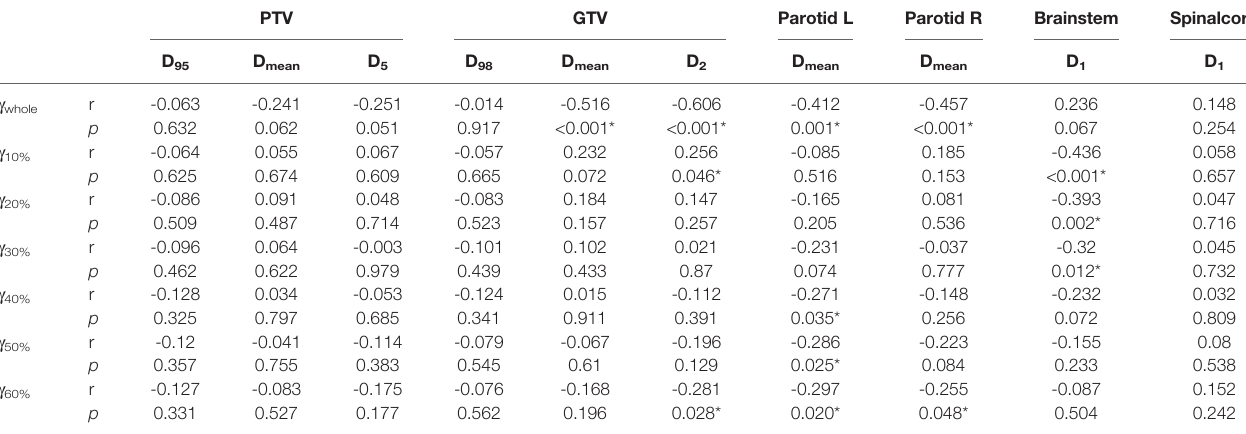
TABLE 1 | The correlation between the %DE and the %GP in different regions for NPC patients. PTV GTV